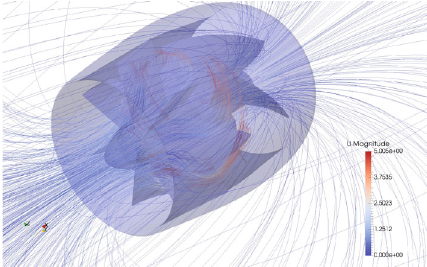
Figure 17: Streamlines in bollard pull mode in the presence of a stator at 600 rpm.